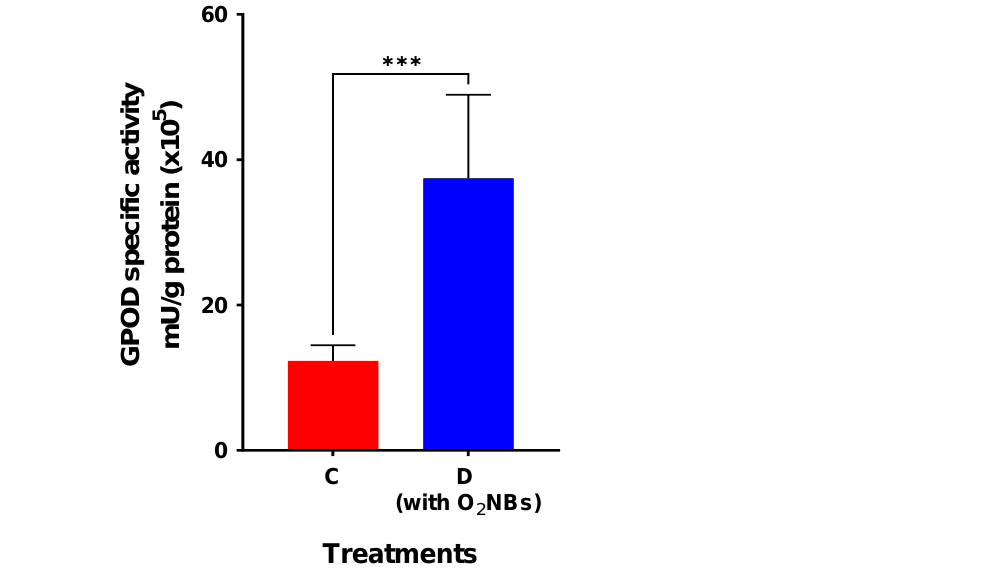
Figure 8. Comparison of GPOD activity in roots per g-protein in the treatments with and without O 2 NBs (star indicates the level of significance: *** for p < 0.001). As seen in Figure 9, in treatment D containing nanobubbles, the accumulation of Fe, Mn, Mg, and Sb from the soil to the plant was enhanced, as each metal concentration (mg/kg DW biomass) was found to be significantly higher in treatment D, which was irrigated with nanobubbles.